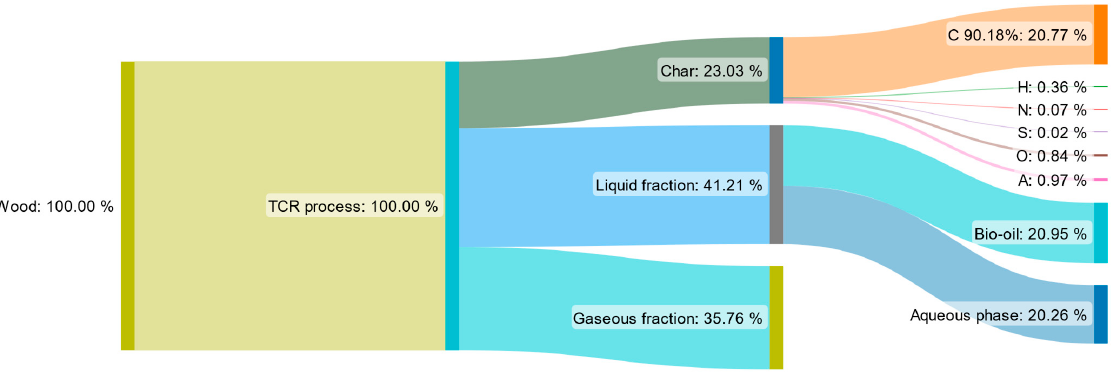
Figure 4. Sankey diagram for pine wood as a feedstock in the TCR process (based on data from [16]).